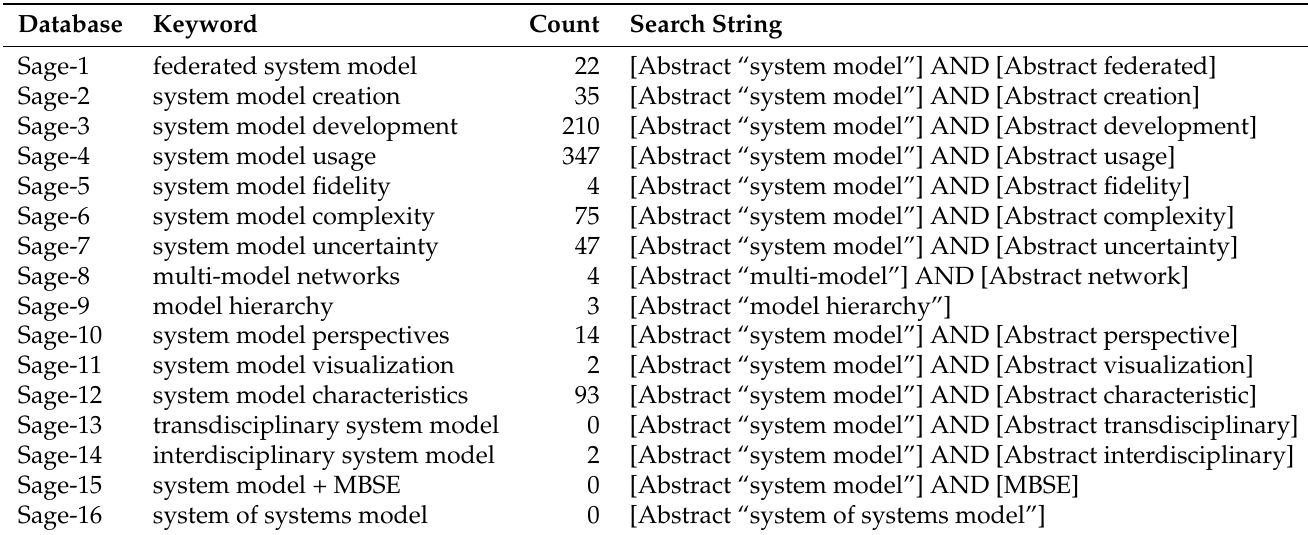
Table A3. Used keywords—Sage.